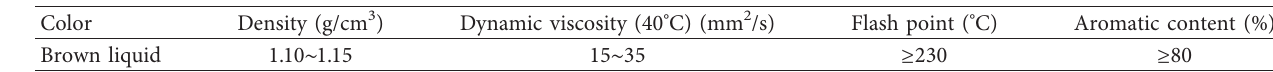
Figure 1: Index curve of aging asphalt in different aging time. Table 2: Indexes of regenerating agent.